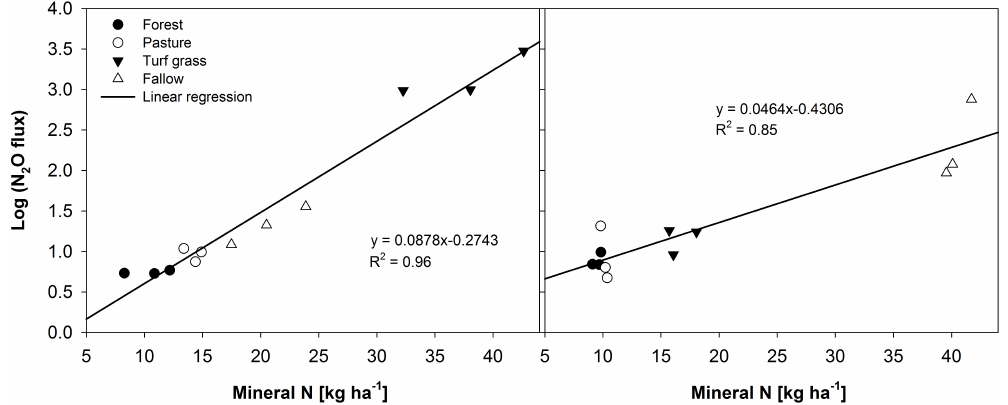
Figure 4. Linear relationship of log-transformed N 2 O emissions with mineral N content at 20cm soil depth for each replicate of forest, pasture, turf grass, and fallow land use during the establishment phase (a) and the rest of the year (b) , with the coefficient of determination R 2